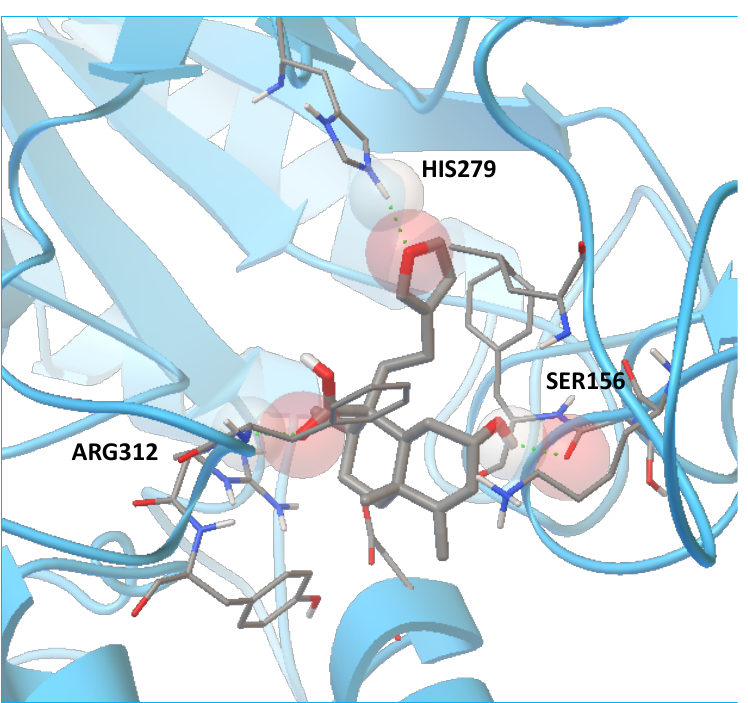
Figure 7. Docking results of the enzyme binding conformation of compound 5 with MAL12, three hydrogen bonds formed with catalytic residues SER156, HIS279, and ARG312.